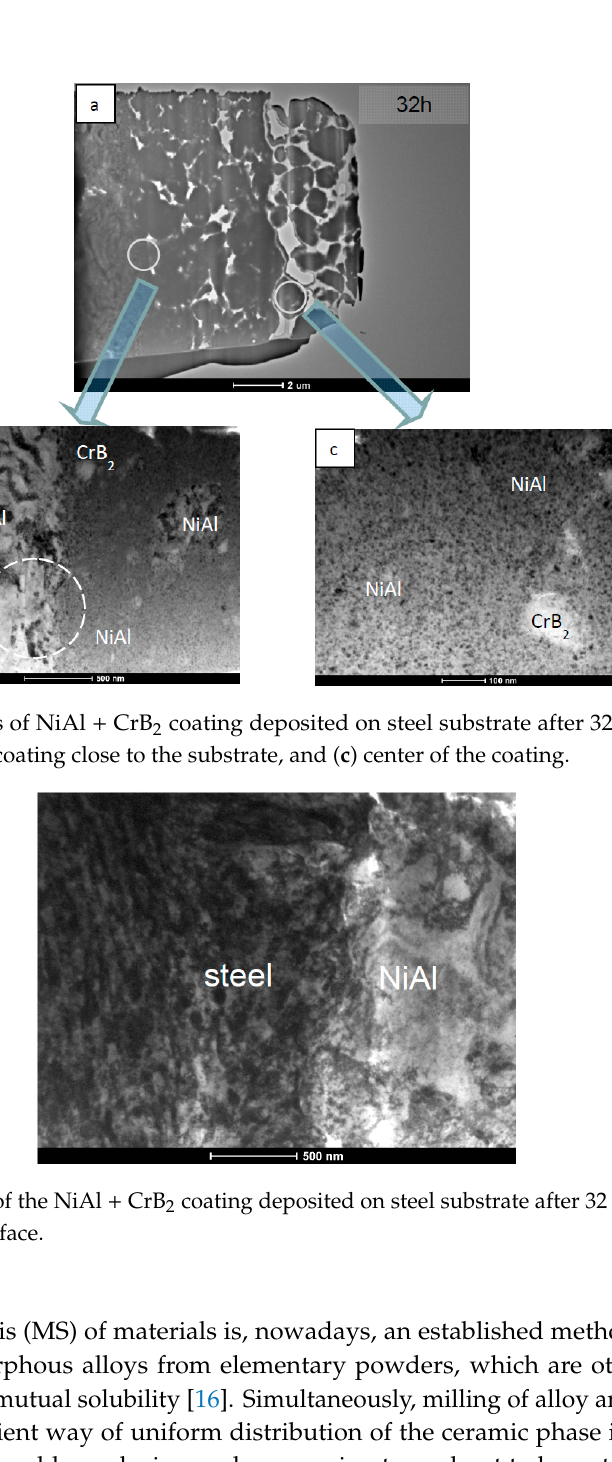
Figure 7. TEM images of NiAl + CrB 2 coating deposited on nickel substrate after 32 h of milling: ( a ) general overview, ( b ) substrate/coating interface, and ( c ) center of the coating.